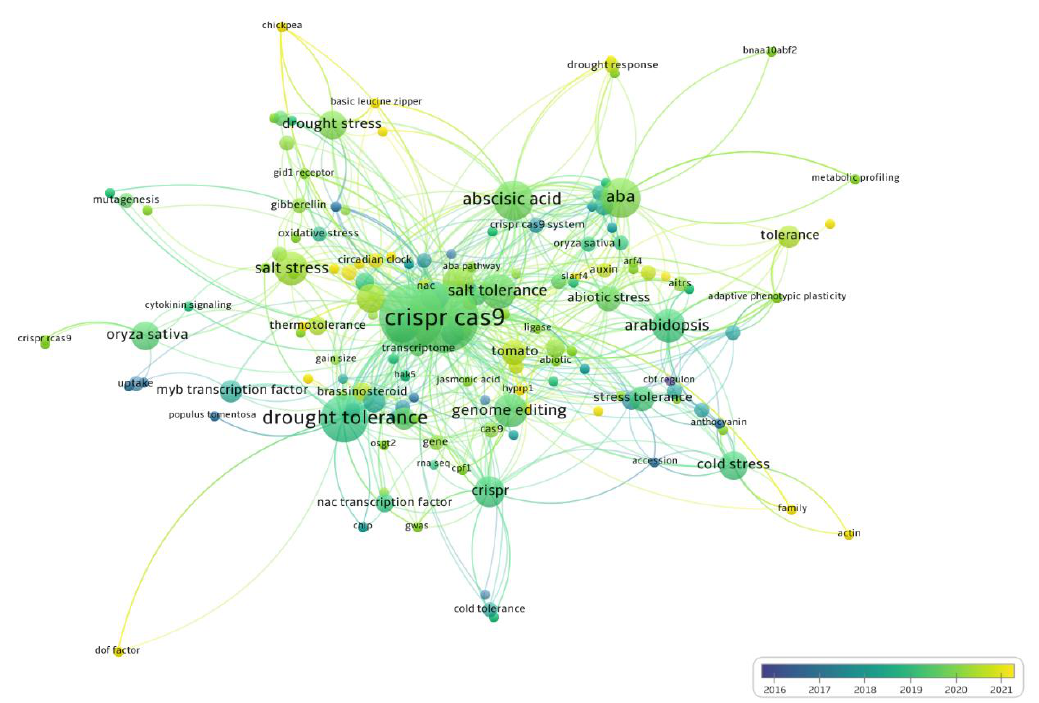
Figure 2. Bibliometric map of the keywords in the selected articles on CRISPR/Cas technology used to edit genes for tolerance to abiotic stresses in plants during the extraction phase of this systematic review.